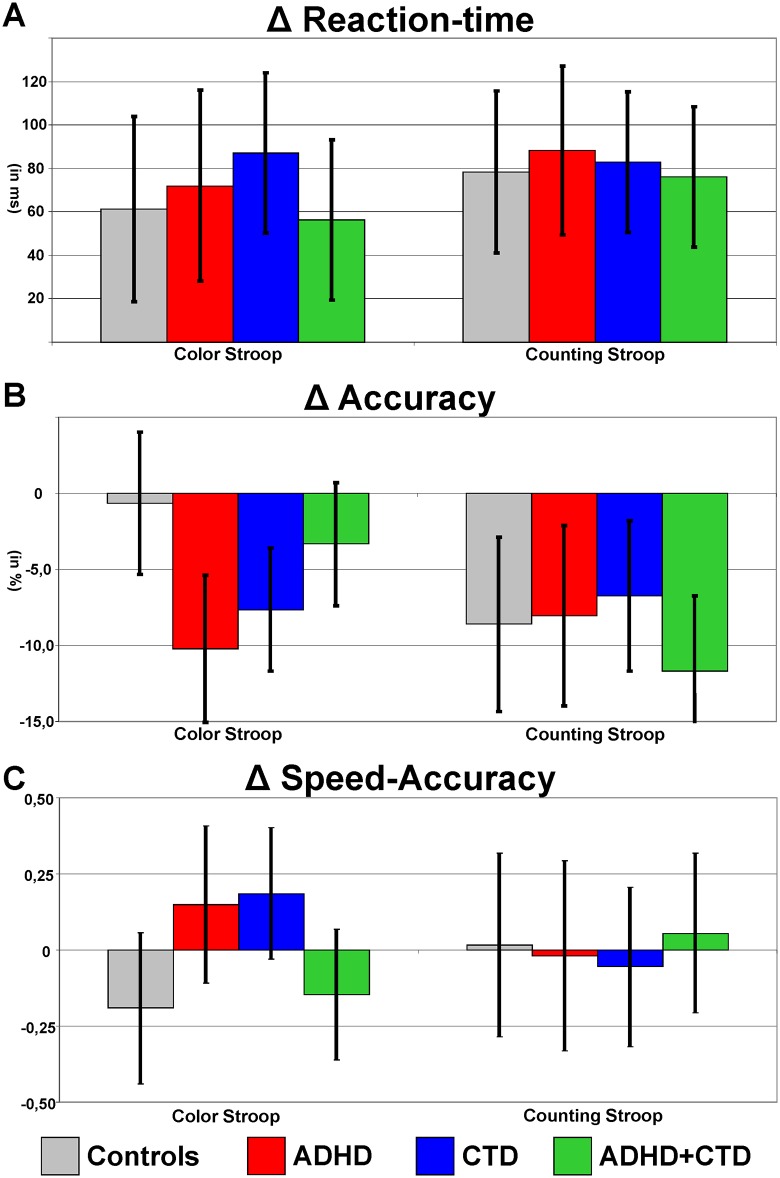
Congruency effects in the single-trial Stroop tasks.This Figure shows confidence intervals (p = .05) of the Congruency effects (as the respective differences in performance parameters between incongruent minus congruent conditions) from Colour- (left) and Counting-Stroop (right). Reaction-times were significantly slower in incongruent trials of both Stroop-Tests in all four groups (as the respective confidence intervals indicated by vertical bars around the respective mean do not include zero), and did not reveal any group-differences (as no mean lie outside the confidence intervals of comparison, see line A, above). Accuracy was significantly lower in incongruent trials of the Counting Stroop similarly for all groups (different from zero and negative in all groups, and all confidence intervals overlap with the respective means), but in the Colour Stroop interference liability on accuracy was present only in the pure ADHD and CTD groups, while Controls and children with ADHD+TIC did not show reduced accuracy in incongruent trials and showed less congruency effect as compared to both other groups (line B). The combined Speed-Accuracy parameter (line C, mean difference incongruent minus congruent trials of z-standardized reaction-time and accuracy scores) showed in the Colour Stroop (left) elevated interference load in the pure ADHD and pure CTD groups than in the controls and comorbid ADHD+TIC groups only, but no significant group differences in the Counting-Stroop (right).